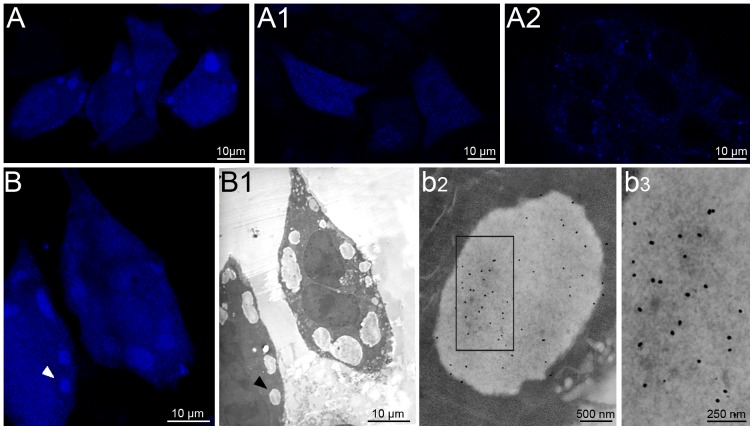
Proteasome activity in PaCSs of living cells.(A) Proteasome chimotrypsin-like activity shown by TED peptide cleavage in living HeLa cells concentrated in cytoplasmic bodies resembling PaCSs in size and intracellular distribution, and (A1) was greatly reduced by epoxomicin treatment. (A2) No comparable fluorescent areas appeared in the cytoplasm of TED-incubated living COS-7 cells. (B) TED-induced proteasome fluorescent bodies in two living HeLa cells under confocal microscopy corresponding in an aldehyde–osmium-fixed resin TEM section of the same cells (B1) to clear spots identified as PaCSs at higher resolution, owing to their faintly contrasted barrel-like particles and selective FK1 immunoreactivity, as shown in (b2) and (b3) for the one arrowhead in (B) and (B1).